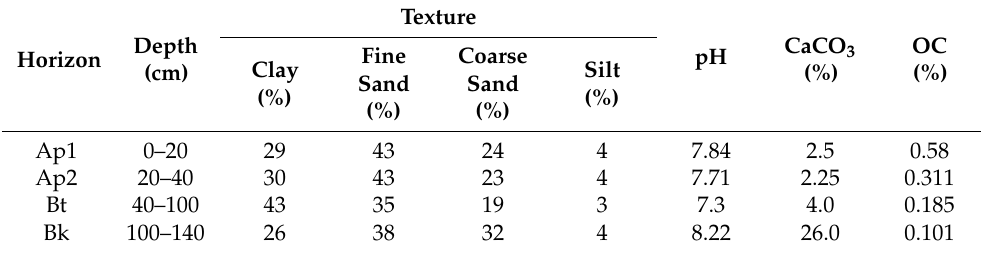
Table 1. Basic properties of the reference soil profile.